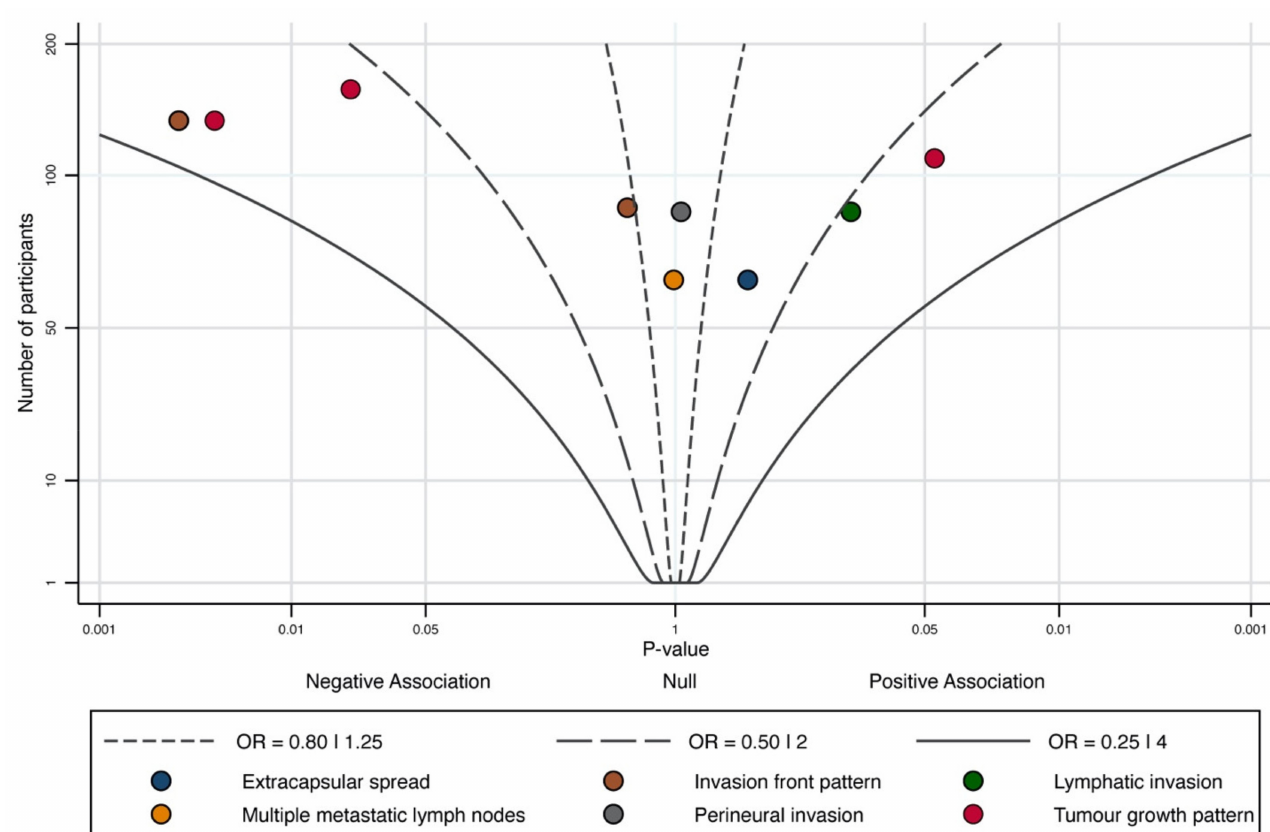
Figure 5. Albatross plot graphically representing the association between the aberrant expression of β -catenin and secondary clinicopathological parameters rarely reported in primary-level studies, but harbouring relevant prognostic implications. Every single study is represented by a circle of different colour, according to the clinicopathological parameter investigated (see legend). Two-sides p -values (horizontal x-axis) with results separated according to positive/negative association (i.e., the observed direction of effect) were plotted against the number of participants included within each study (vertical y-axis). The albatross plot allows a better interpretation of p -values from the variables that did not enter in the meta-analysis, in the context of the study sample sizes. Small studies lie toward the bottom of the plot and large studies toward the top. Effect contours (black continuous and intermittent lines) were drawn on the plot showing the ranges of the magnitudes of effect, using odds ratios (OR). A p -value < 0.05 was considered